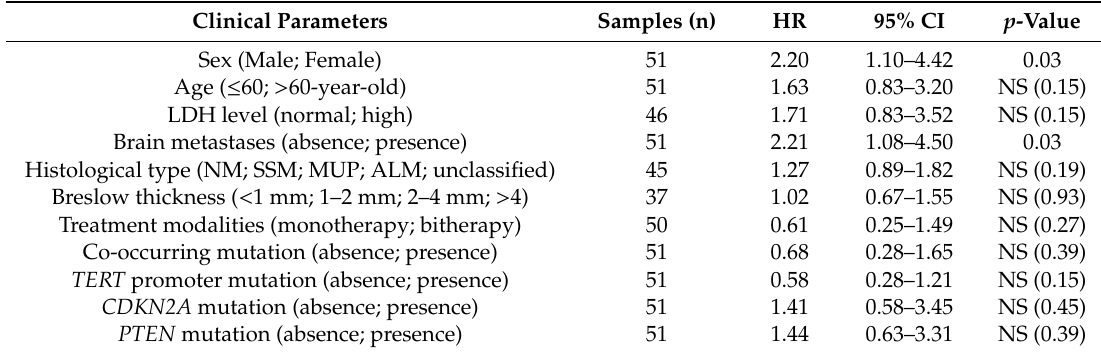
Table 4. Univariate analysis of clinical parameters and sample mutational status with regard to overall survival (OS) in BRAF V600